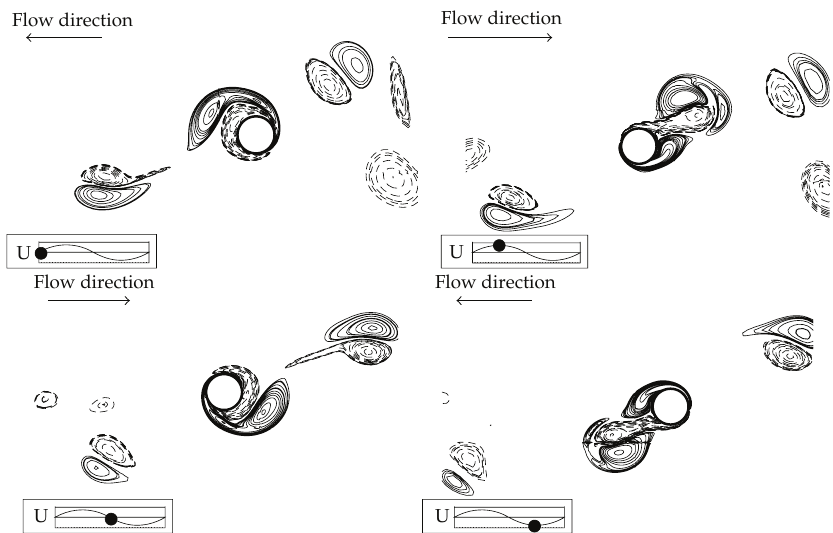
Figure 4: Evolution of vorticity distribution at KC (cid:8) 10 and Re (cid:8) 200. Dash lines refer to the negative vorticity